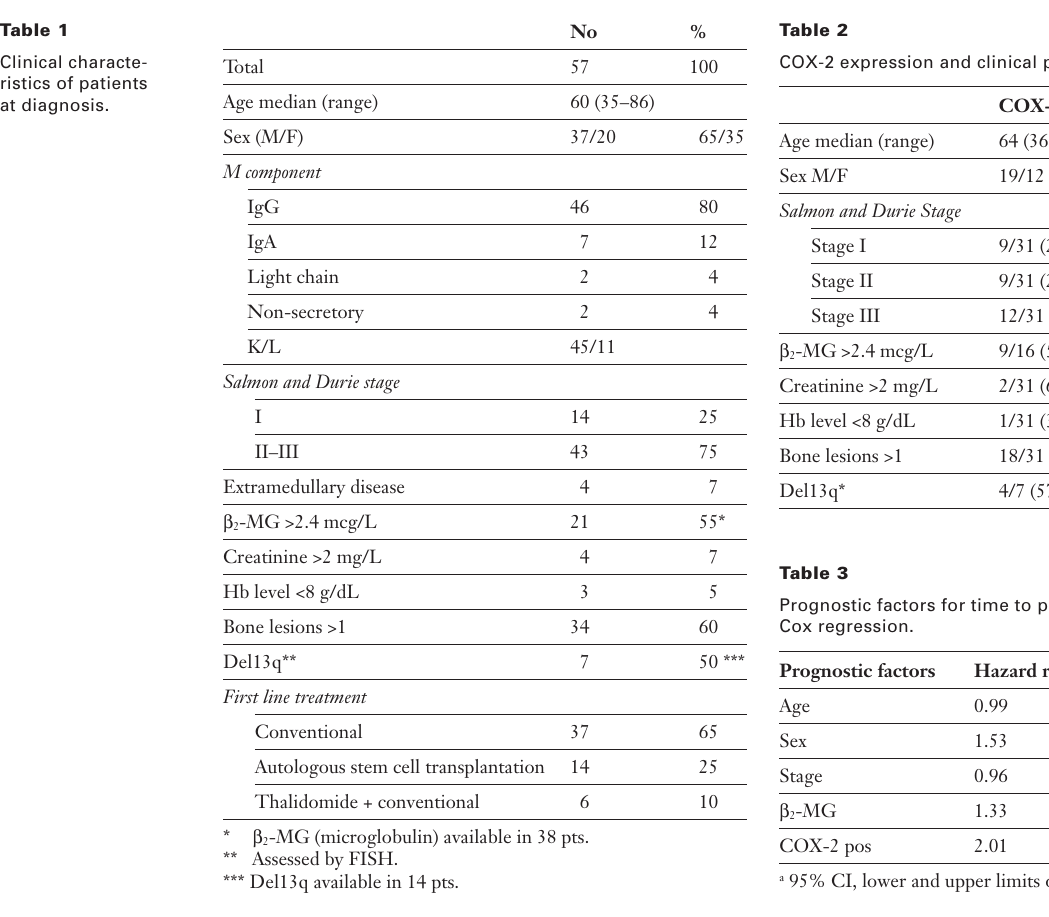
COX-2 expression in reactive tissues, MGUS and multiple myeloma (MM).